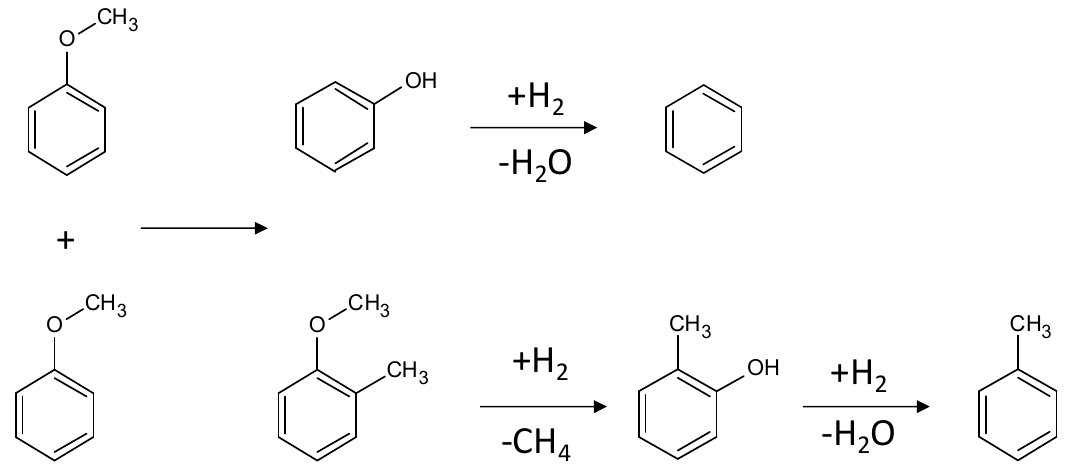
Figure 15. Reaction scheme for HDO and transalkylation of anisole at 400 °C under 1 bar over Pt-Sn/CNF adapted from ref. [48].